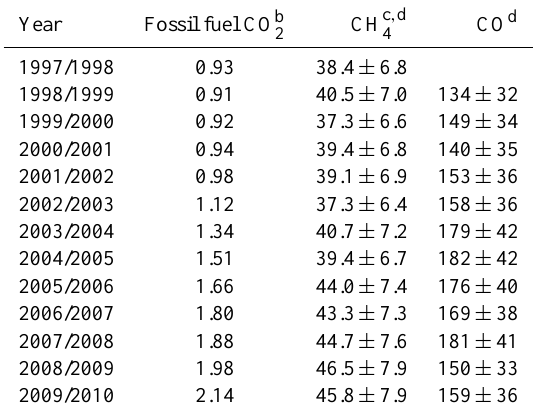
− 1 , for CH − 1 , and for a Values for CO 2 are given in PgCyr 4 in TgCH 4 yr CO in TgCOyr − 1 . b Fossil CO 2 emissions are taken from the CDIAC database. Each value is the average of the emissions for the consecutive two years described in the first column. The uncertainty is assumed to be 15%, Fig. 9. Comparison of estimated nonseasonal CH 4 emissions from which is the lower limit of the estimation of Gregg et al. (2008). c Values China. The values are expressed as annual emissions. Closed blue represent the emissions from nonseasonal CH 4 sources (see text). d Uncertainties are calculated from the uncertainties of the squares are the estimated emissions of this study. Green circles, fossil-fuel-derived CO 2 emissions in China, of the observed correlation light-blue squares, and light-blue circles represent the CH 4 emis- slopes including the influence of the correlation coefficient criteria sions from anthropogenic sources (excluding rice fields) in China selection, and of the simulated correlation slopes including the influence of the uncertain emission distributions used in the simulation (see text). based on the emission inventories from EDGAR v4.2 (http://edgar. jrc.ec.europa.eu/), REAS v1.1 (Ohara et al., 2007) and REAS v2.1 (Kurokawa et al., 2013), respectively.